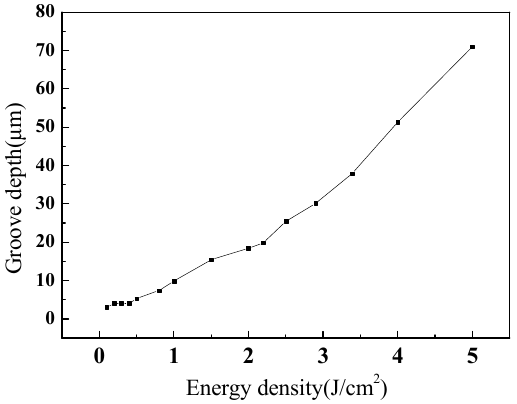
Figure 7. The depth of groove texture of nickel at different energy densities.